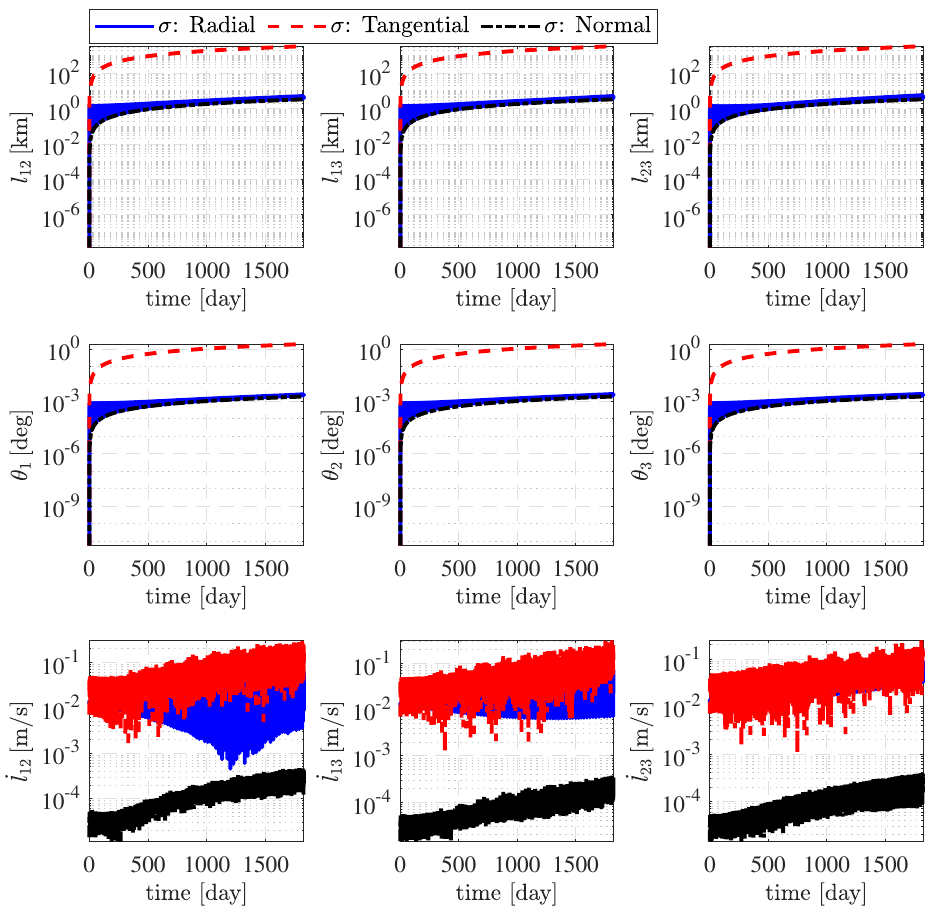
Figure 11. Effects of velocity insertion errors in different